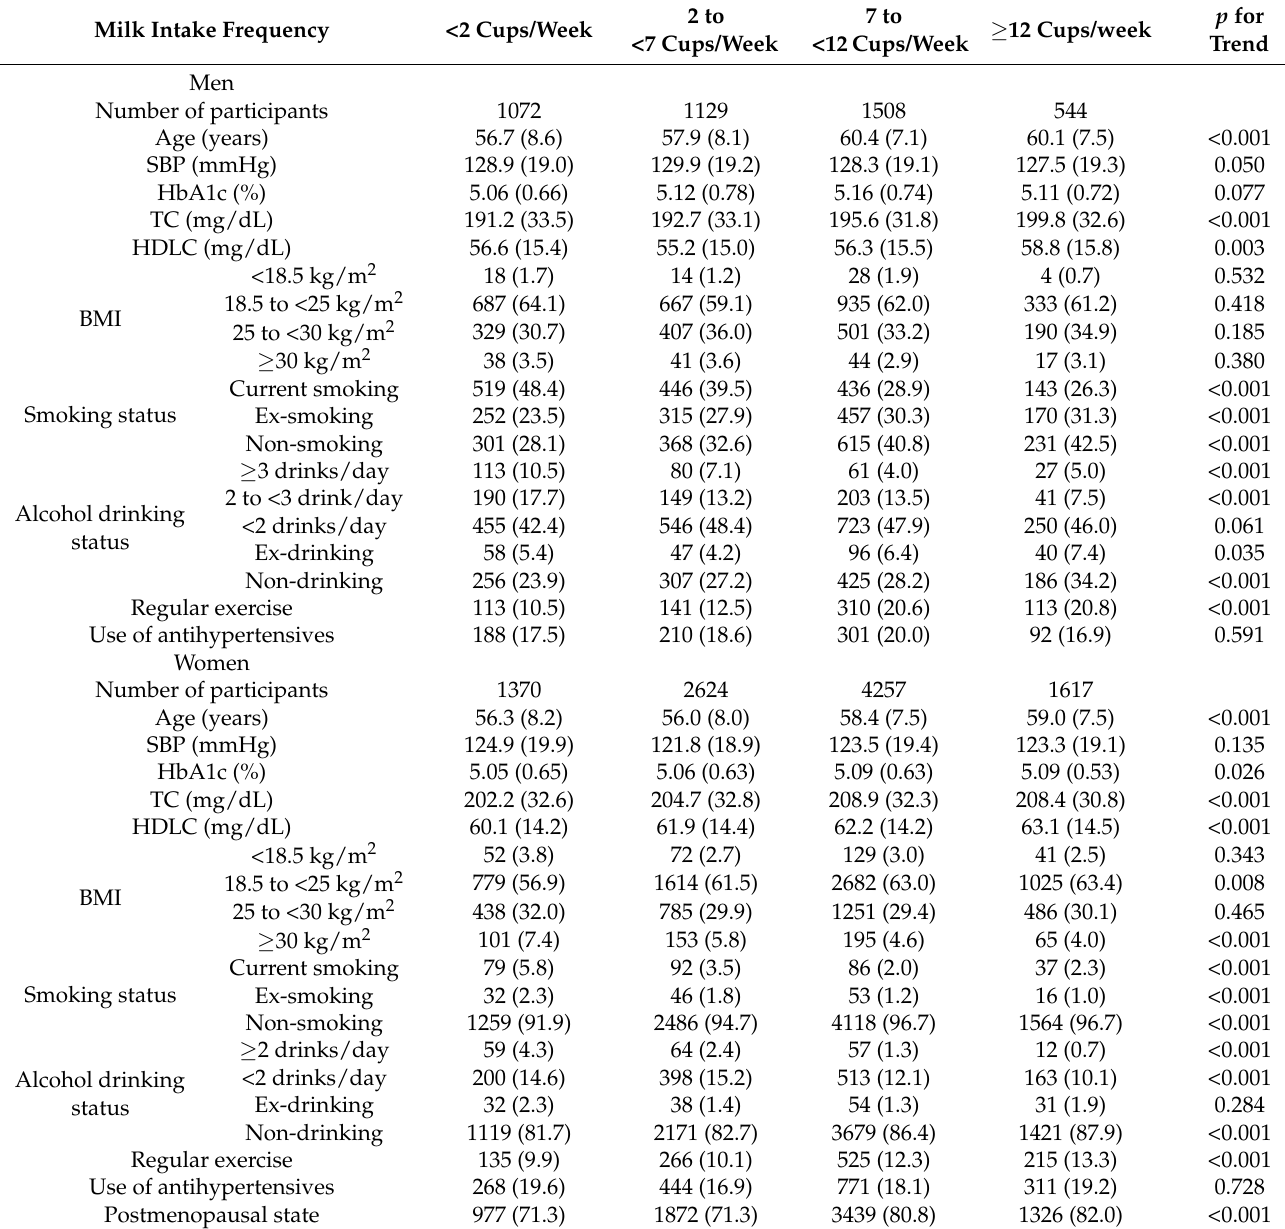
Table 1. Baseline characteristics of participants according to milk intake frequency categories by sex, 2002–2005, Iwate- KENCO